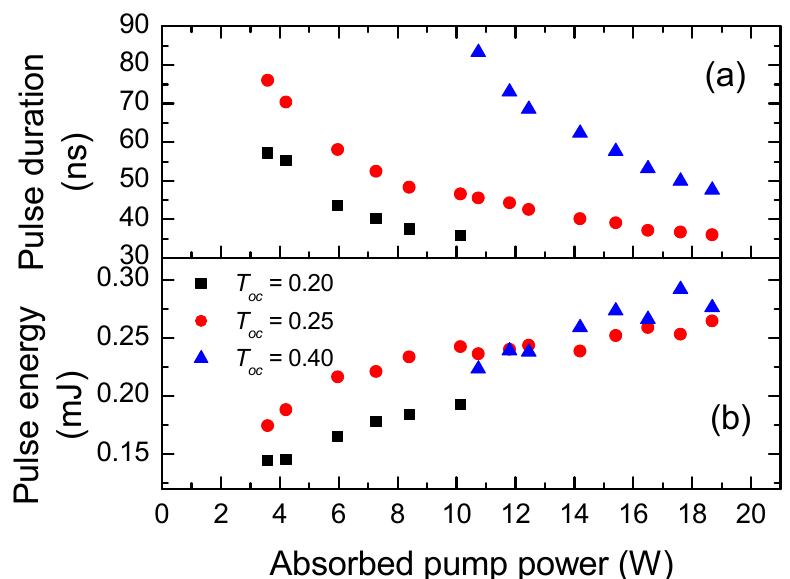
Figure 3. ( a ) Pulse duration and ( b ) energy vs. absorbed pump power.